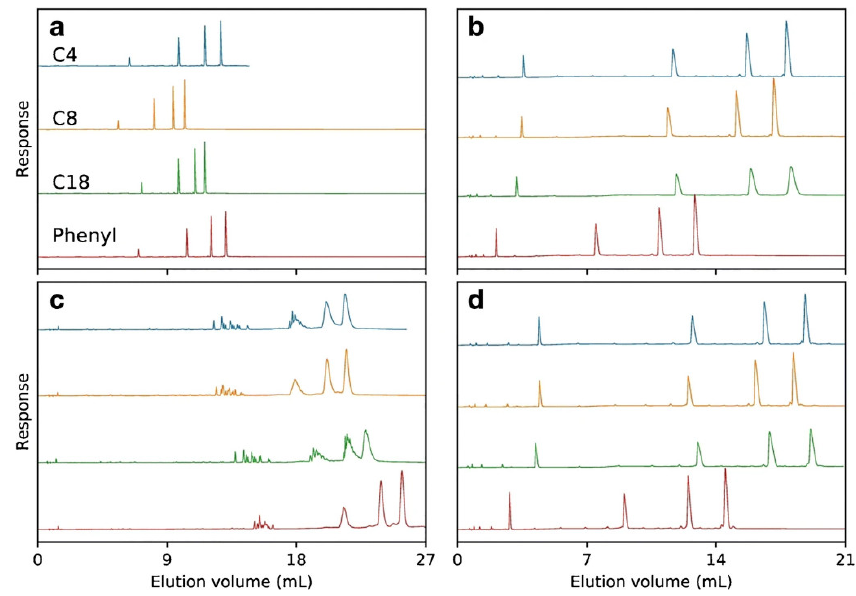
Figure 5. A mixture of T5, T10, T15, and T20, separated on Kromasil C4, C8, C18, and phenyl columns using either triethylammonium acetate (TEtAA) or tributylammonium acetate (TBuAA) as an ion-pairing reagent. Plot ( a ) shows chromatograms using native oligonucleotides eluted in 50 mM TEtAA. In plot ( b ), the same sample is separated using 5 mM TBuAA. Plots ( c ) and ( d ) show the elution profiles of a PSmodified oligonucleotide, under identical conditions as in ( a ) and ( b ), respectively (reprinted from Ref. [62], Open Access article distributed under the terms of the Creative Commons Attribution 4.0 International License).